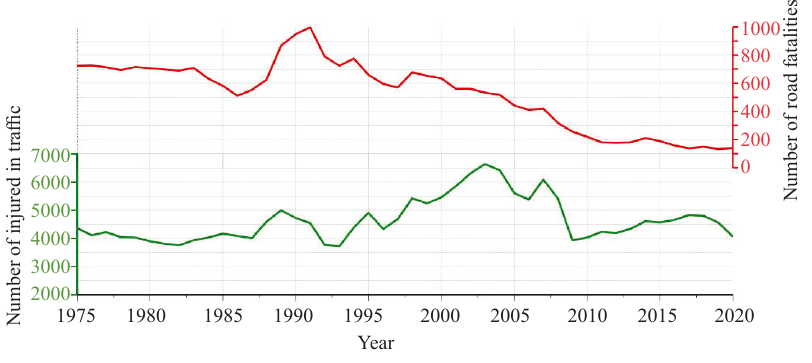
Figure 7. Road traffic accident fatalities in